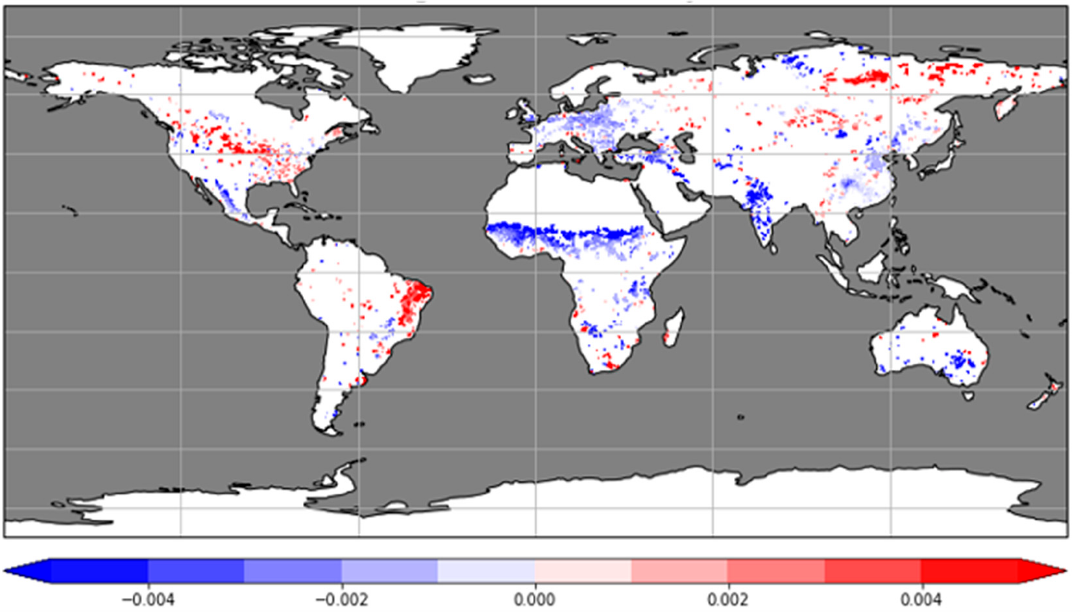
Figure 5. Linear trend of b/y [-] (see Section 3) from 2003 to 2019. Pixels which show a statistically significant trend (Student’s t -test, p < 0.05) are depicted.